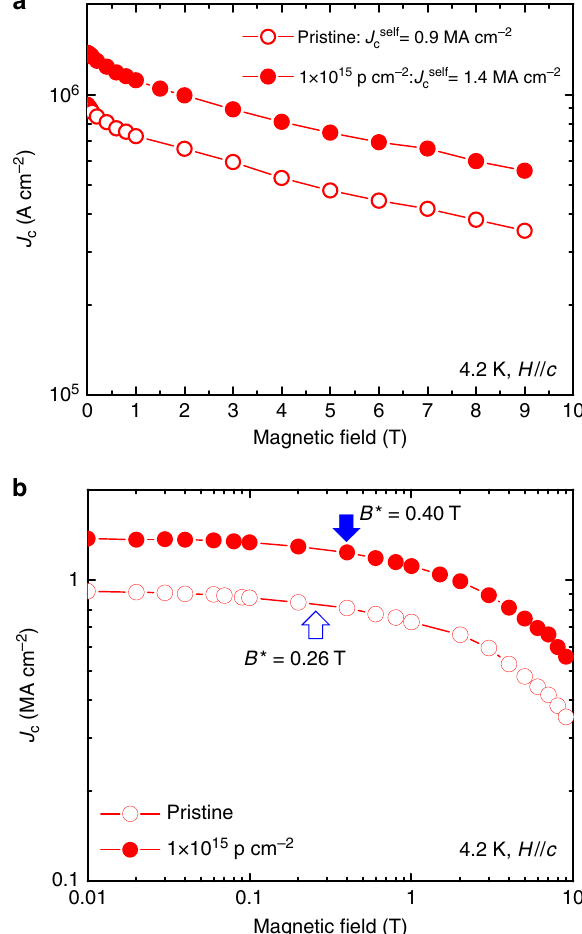
Figure 5 | Critical current density as a function of magnetic fields up to 9T. ( a ) J c ( H // c ) for the FST film before and after 190keV proton irradiation with 1 (cid:2) 10 15 pcm (cid:3) 2 dose at 4.2K. ( b ) Same data plotted in log-log scale. The arrows indicate the field of the crossover field B (cid:4)